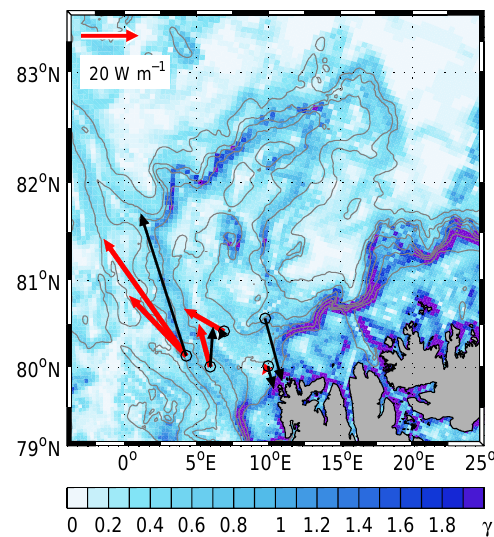
Figure 9. Contours of γ , the ratio of semidiurnal internal wave characteristic to the bottom slope. An effective inertial frequency of 0 . 95 f (i.e. assuming negative, anti-cyclonic, relative vorticity of 0 . 05 f ) is used in the calculations. Superimposed are the iso- baths (250, 500, 750, 1000, 1500, 2000, and 3000m), station posi- tions (circles), and the depth-integrated baroclinic semidiurnal en- ergy flux (arrows) with scale given on the top left. Red arrows are inferred from the observations, whereas the black arrows are from STORMTIDE (sum of M 2 and S 2 ) averaged over 10km range of the stations. At station 1 the two observed flux vectors are obtained from the VM-ADCP and the XCP